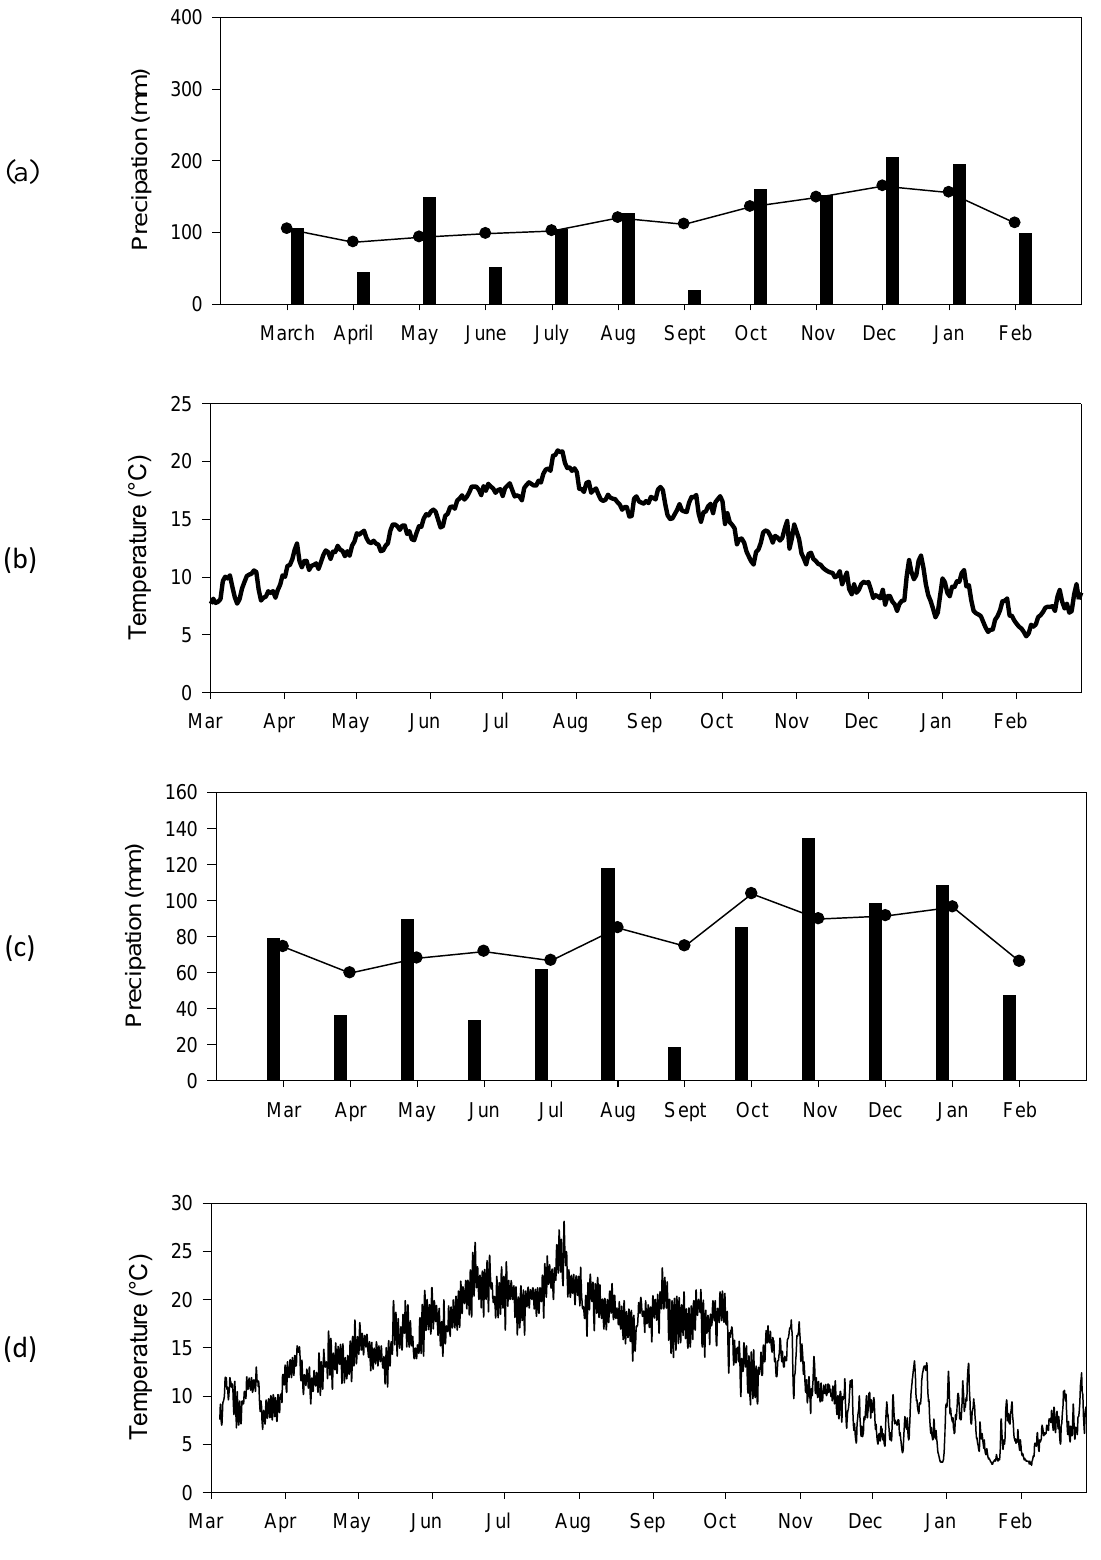
Figure 3. Rainfall and soil temperature data for Pollagoona, County Clare and Scohaboy Bog, County Tipperary, during the study period March 2014 to February 2015: (a) monthly rainfall (mm) (Met Eireann, Gort rainfall Station); (b) soil temperature (°C) at 5 cm depth at Pollagoona; (c) monthly rainfall (mm) (Met Eireann, Gurteen Station); (d) soil temperature (°C) at 5 cm depth at Scohaboy. The filled circles and lines indicate 30-year averages (1981–2010,